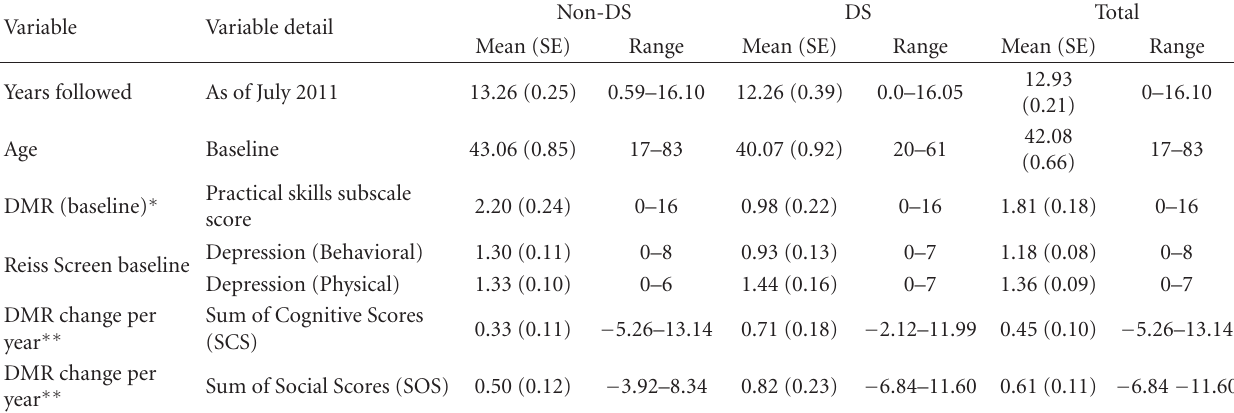
Table 3: Summary of key variables entered into the survival model (continuous variables).